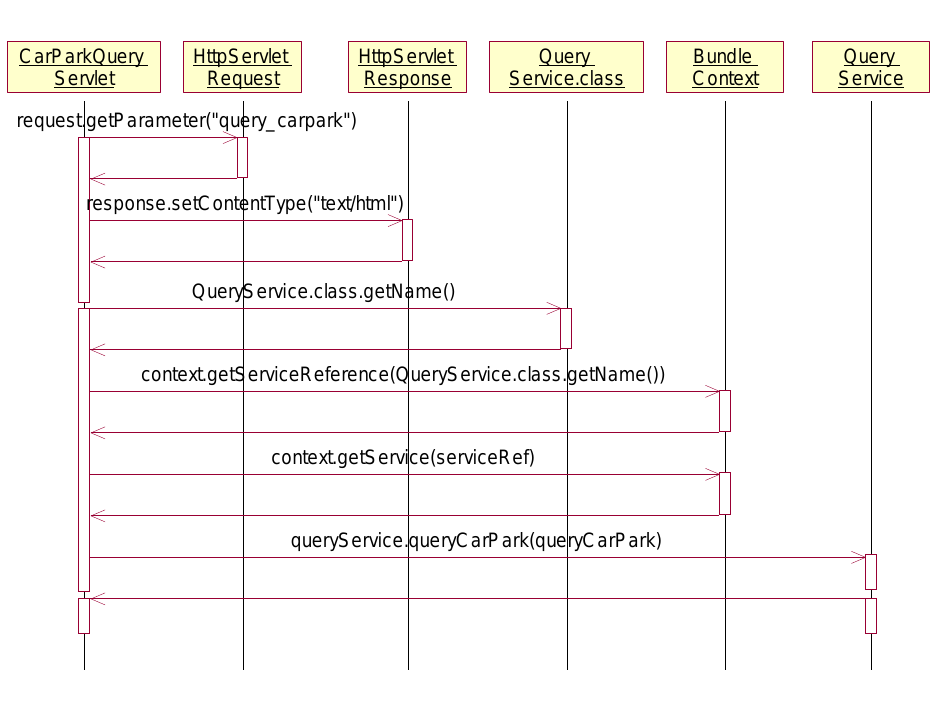
Figure 12. The car-parking-lot query function with OSGi bundles.